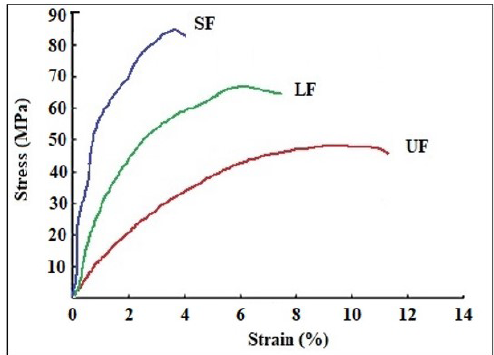
Figure 4. Stress-strain curve of pure and reinforced epoxy composites.